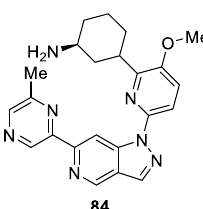
Figure 6. Chemical structure of azaindazole derivative 84.